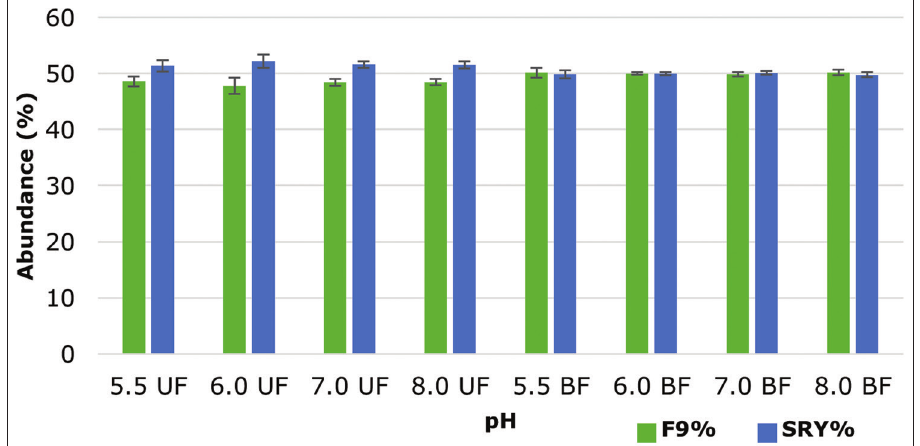
Figure-1: Abundance of X- and Y-chromosome-bearing sperm in upper and lower fractions collected from Ringer’s lactate solution having a different pH (UF: Uppermost fraction, BF: Bottom fraction). The data are displayed as mean ± standard error of the mean for three independent experiments.